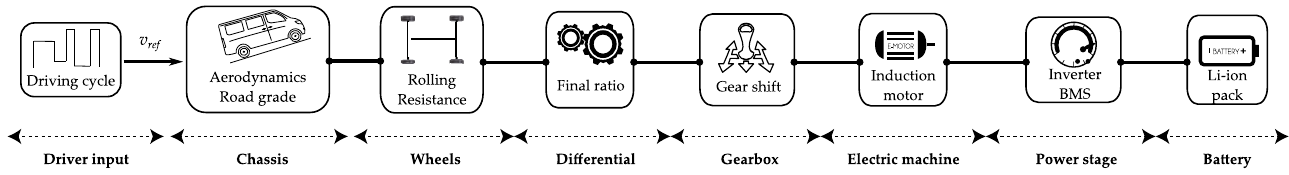
Figure 6. Block diagram of the operation of the backward dynamic model for an electric vehicle in MATLAB/Simulink ®